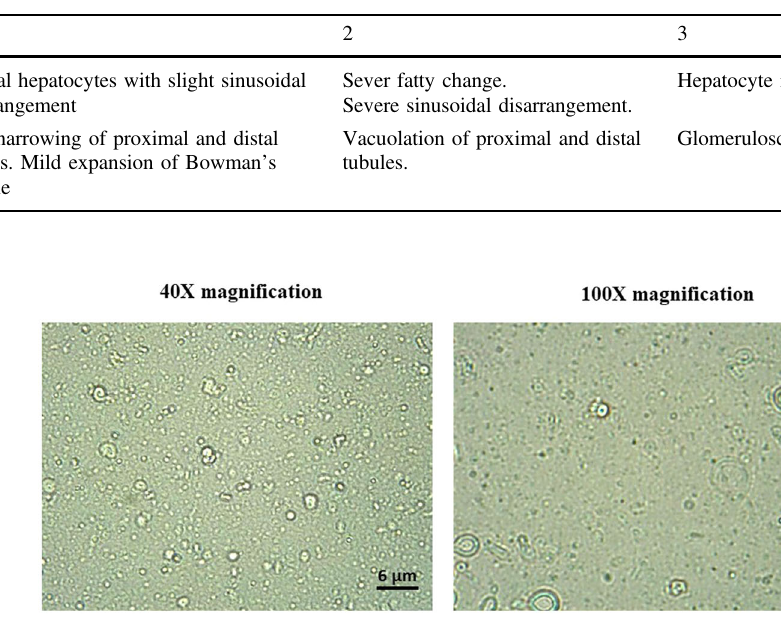
Table 1 The classi fi cation of hematoxylin and eosin-stained sections injuries - hepatic damage score (HDS), renal damage score (RDS) Description